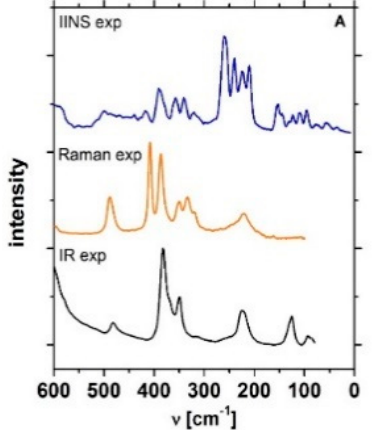
Figure 8. The experimental infrared (IR), Raman, and inelastic incoherent neutron scattering (IINS) spectra of 1,1 ′ ,1 ″ -(2,4,6-trihydroxybenzene-1,3,5-triyl)trietanon measured in the solid state. Reproduced from Ref. [46] with permission from the Centre National de la Recherche Scientifique (CNRS) and The Royal Society of Chemistry.